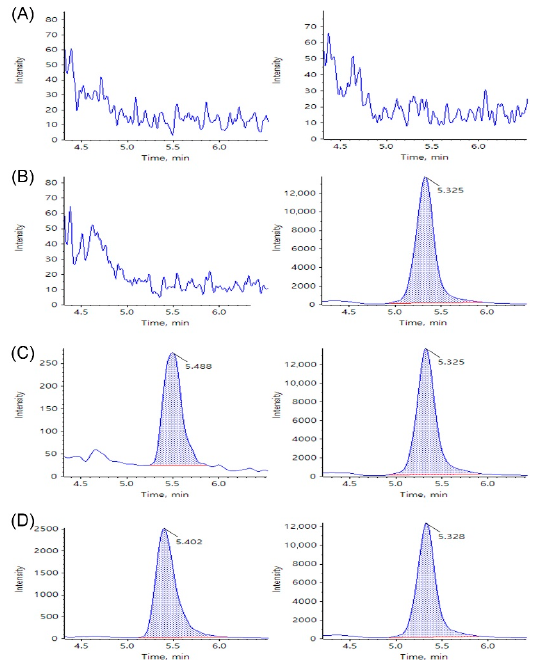
Figure 2. Selected reaction monitoring (SRM) liquid chromatography-tandem mass spectrometry (LC-MS/MS) chromatograms of sirolimus ( left ) and IS ( right ) obtained by deproteinization of ( A ) blank porcine whole blood, ( B ) blank porcine whole blood spiked with 1 ng/mL of IS, ( C ) blank porcine whole blood spiked with sirolimus at lower limit of quantification (LLOQ) 0.5 ng/mL and 1 ng/mL of IS, and ( D ) a porcine whole blood sample at 5 min in the pharmacokinetic studies.